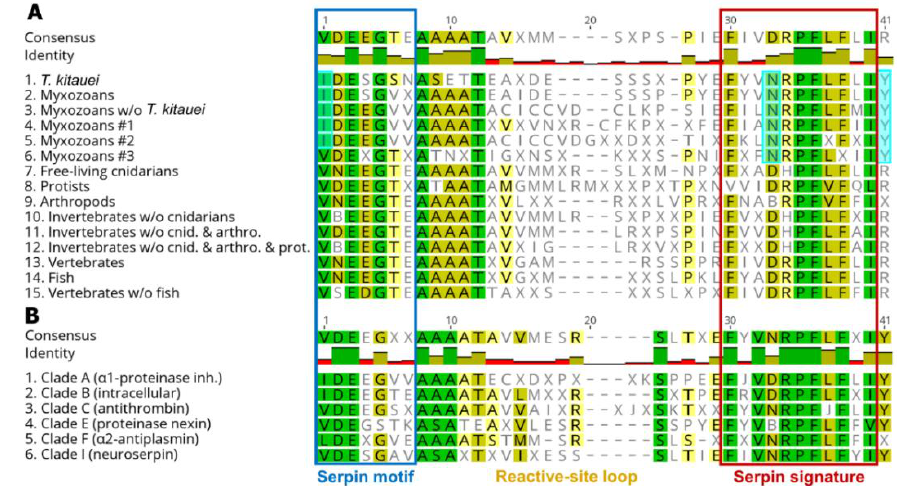
Figure 2. Comparison of consensus amino acid sequences of conserved serpin domains, motif and signature, sorted by ( A ) taxon, and ( B ) serpin type classified in clades. Amino acid positions, which differ in myxozoans compared to other taxa, were highlighted pale blue.